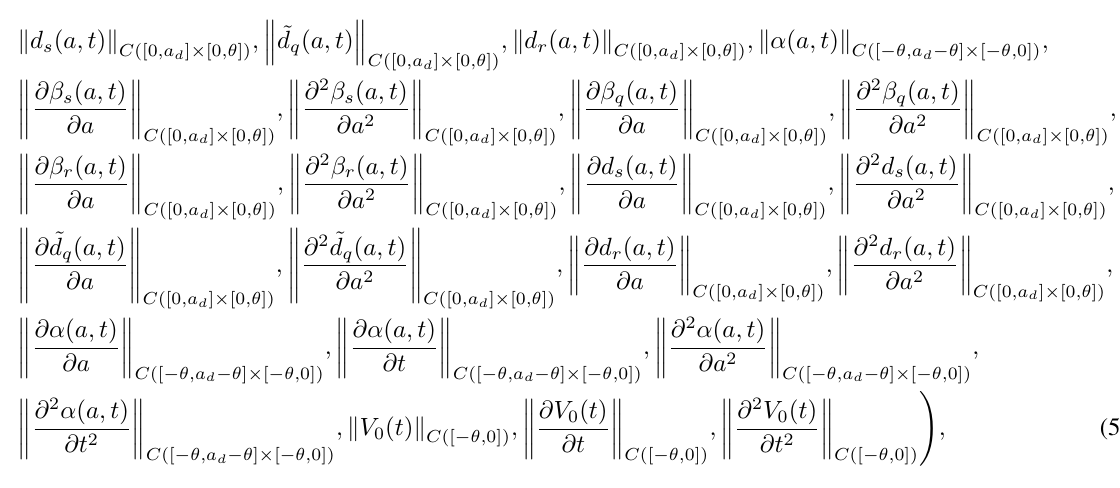
A PPENDIX D. E STIMATION OF THE RESIDUAL OF CANCEROUS CELLS SUBCLASS DENSITY